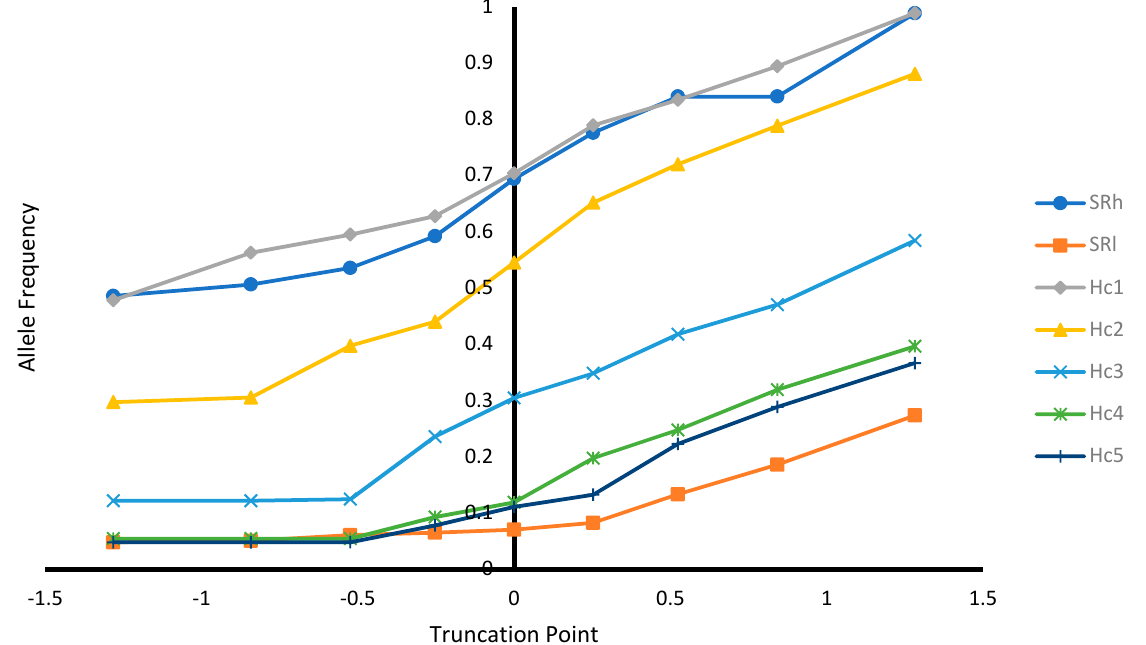
Figure 3. Allele frequency at different selection truncation points in unit of standard deviations.